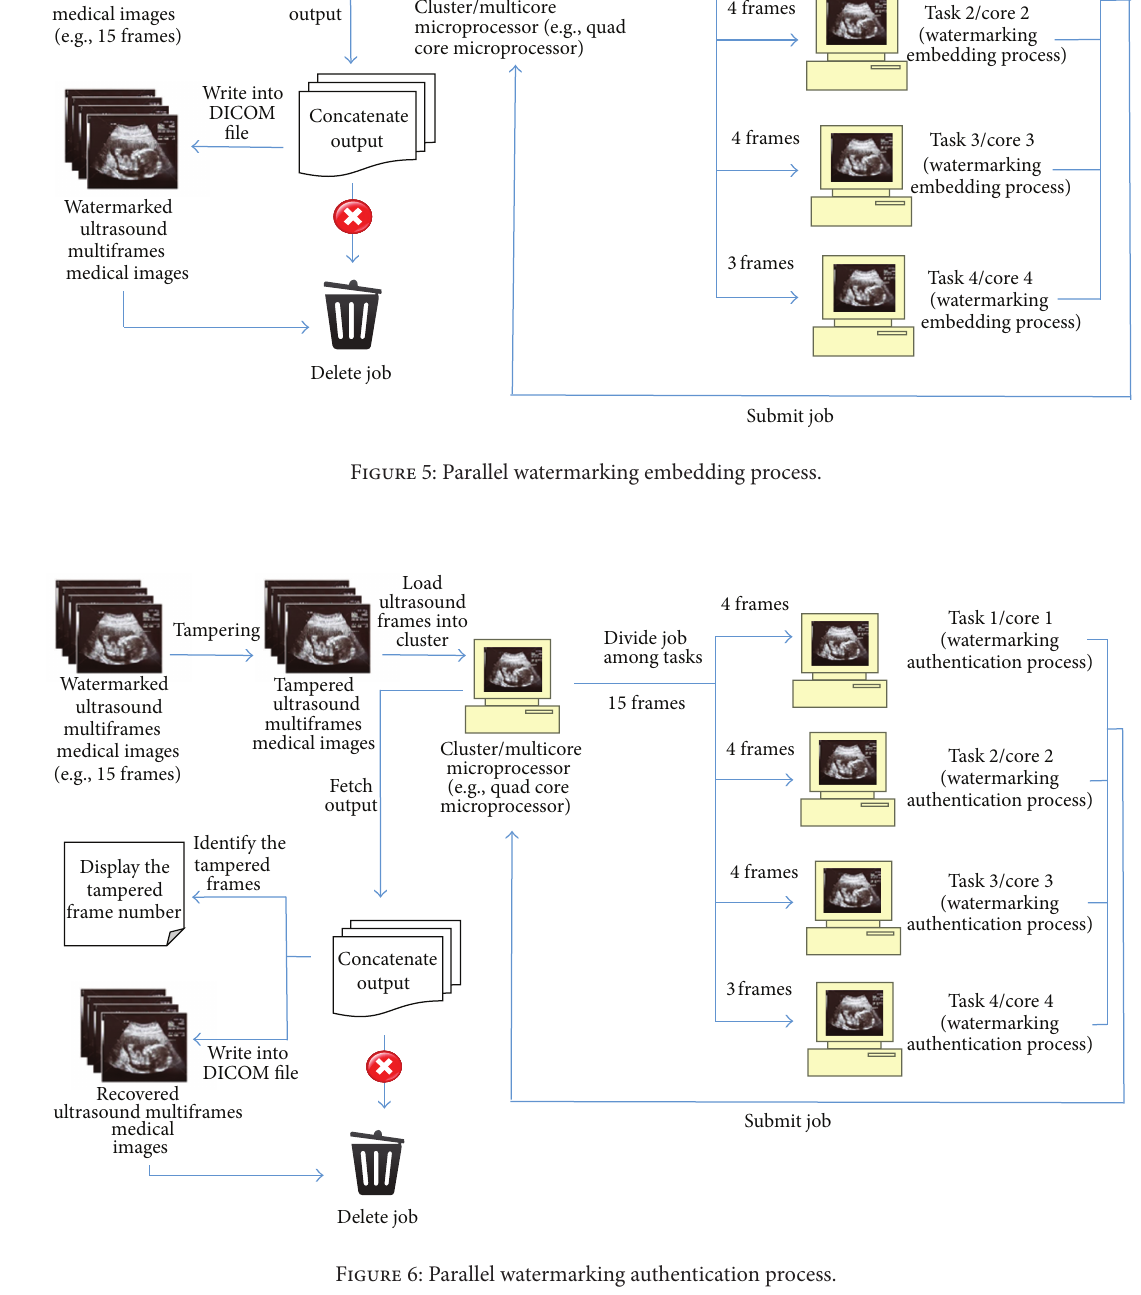
Figure 6: Parallel watermarking authentication